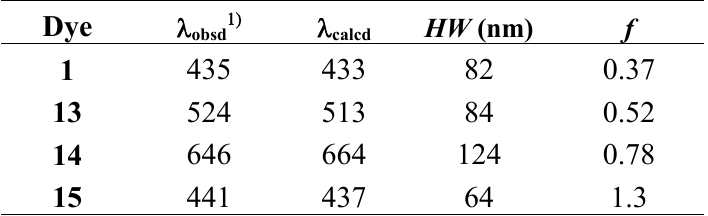
Table 4. The observed and calculated properties of anthraquinone and coumarin dyes.